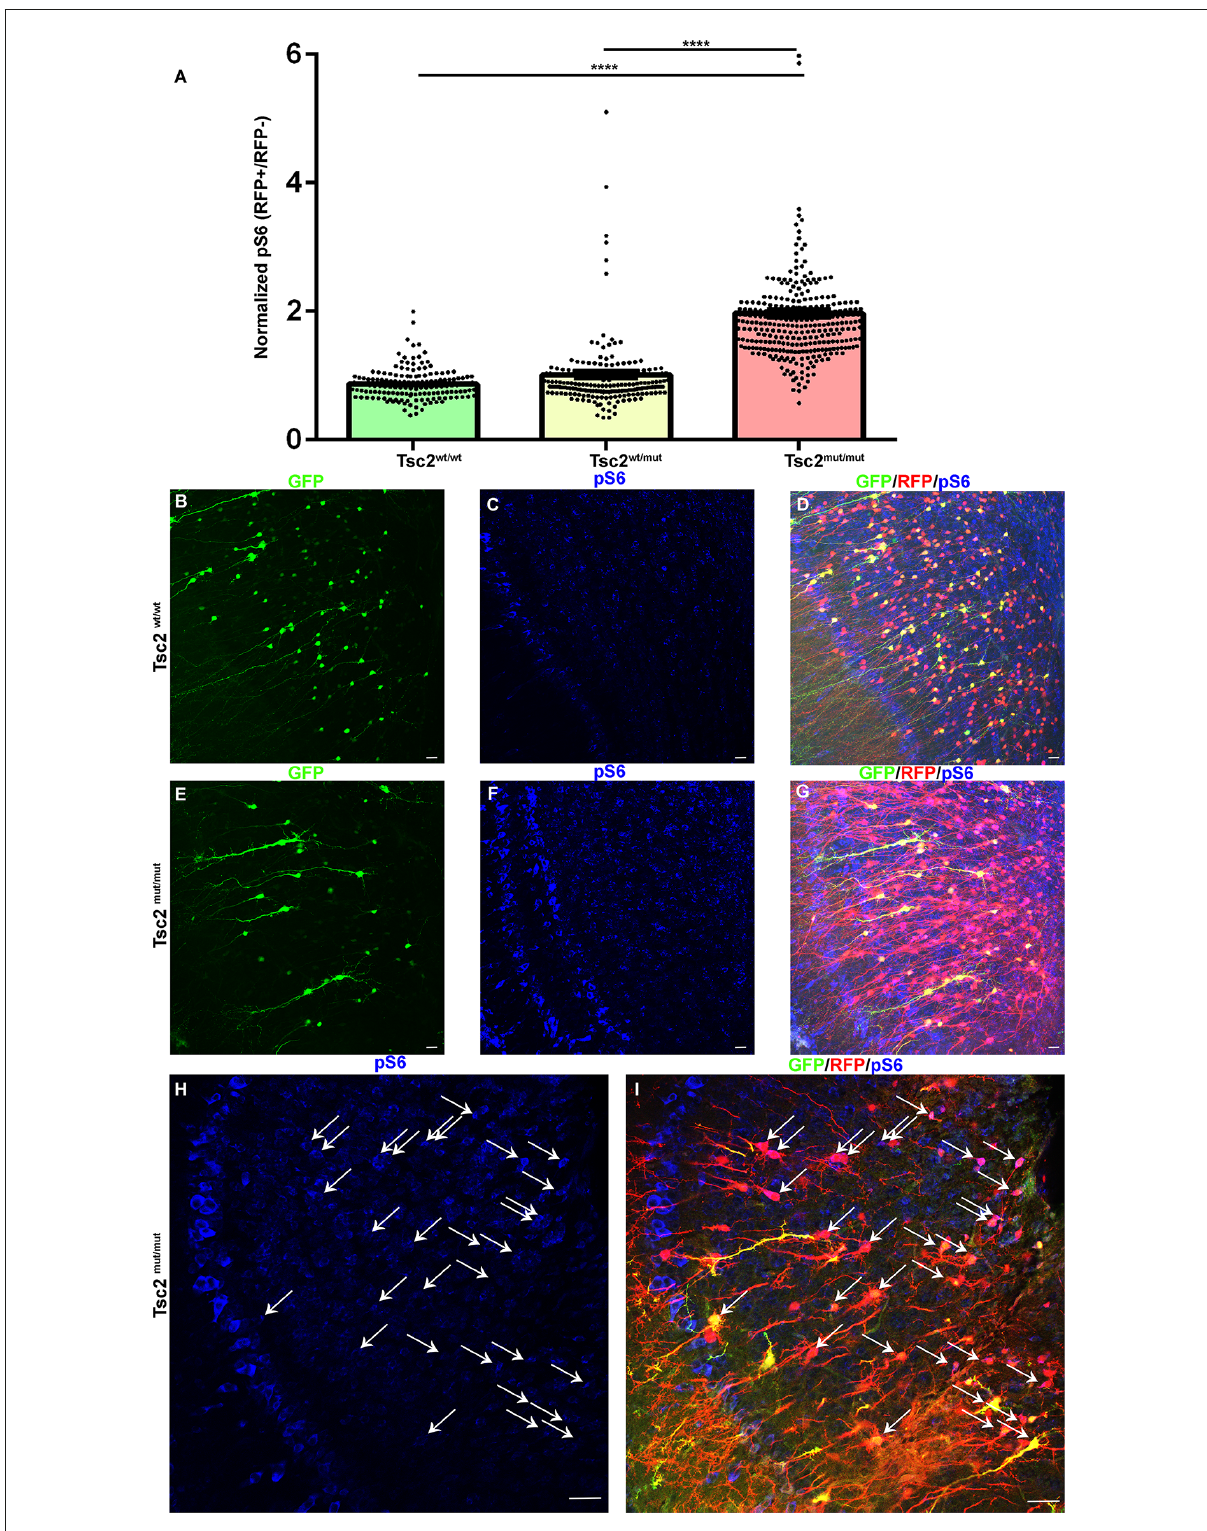
FIGURE4 Loss of Tsc2 in OB granule cells activates the mTOR pathway. (A) Quantification of relative pS6 levels. (B–I) 20 × confocal images of coronal sections of OB GCs labeled with GFP (green) demonstrating recombination and expression of RFP (red), and pS6 staining (blue). Arrows indicate Tsc2 mut/mut GCs with elevated pS6. **** p <